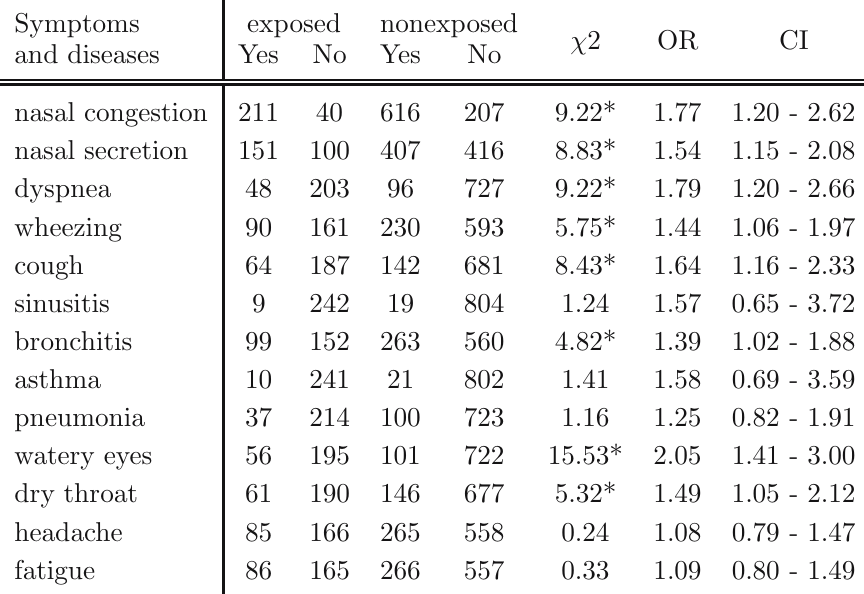
its influence on children’s